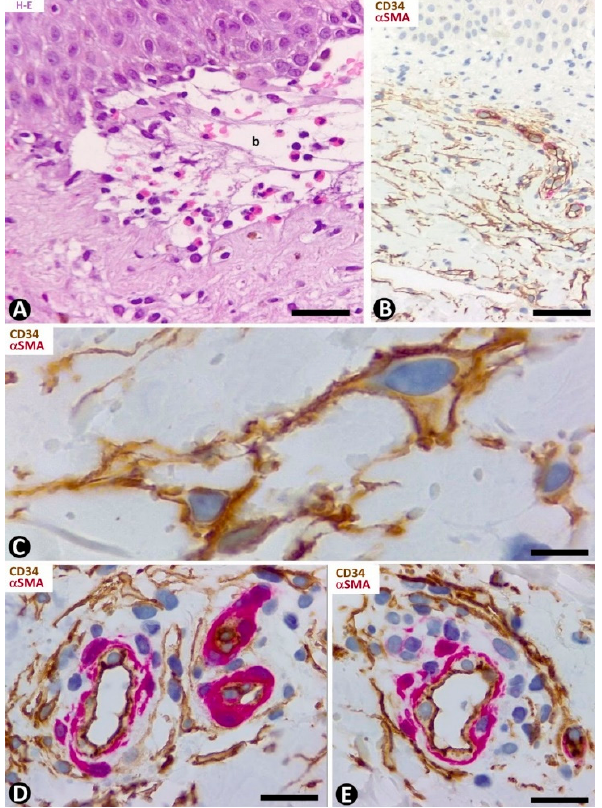
Figure 8. CD34+SCs/TCs in bullous pemphigoid. ( A ) Hematoxylin–eosin staining. ( B – E ) Double immunochemistry for CD34 (brown) and α SMA (red). Hematoxylin counterstain. ( A ) Subepidermal blister (b), with the presence of eosinophils in the blister cavity. ( B ) CD34+SCs/TCs (brown) in the superficial dermal layer. ( C ) CD34+SCs/TCs observed at high magnification in the interstitium of the superficial dermal layer. ( D , E ) Perivascular CD34+SCs/TCs surrounding a slight lymphohistiocytic infiltrate. Bar: ( A ) 55 µm, ( B ) 80 µm, ( C ) 15 µm, ( D , E ) 25 µm.